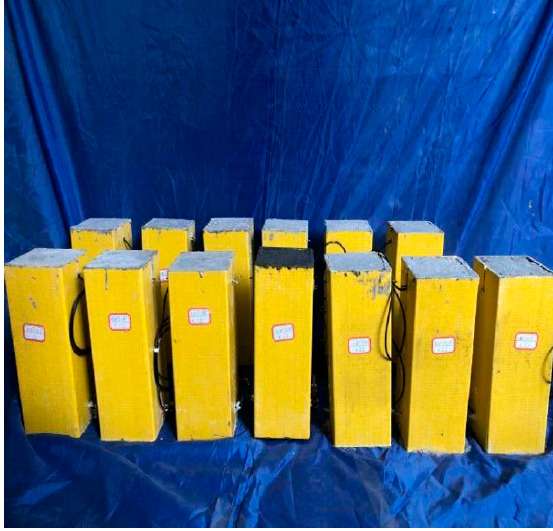
Figure 4. Concrete with different nano-SiO 2 contents.